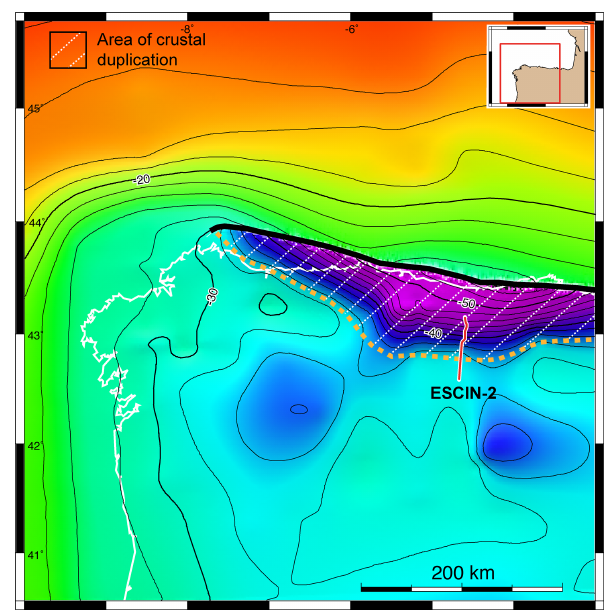
Figure 2. Interpolated crustal depth model for the NW of the Iberian Peninsula from Gallastegui (2000). The dashed area shows the ex- tent of the area of crustal indentation. Moho depth contours are rep- resented every